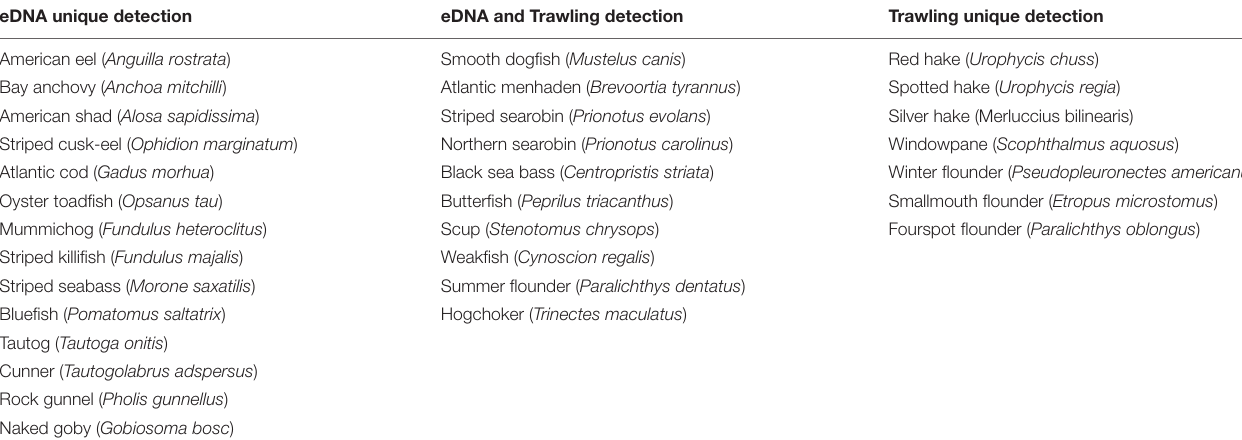
TABLE 4 | Finfish uniquely detected by eDNA, commonly detected by eDNA and trawling, and uniquely detected by trawling on 6/27/2017 in Long Island Sound. eDNA unique detection eDNA and Trawling detection Trawling unique detection American eel ( Anguilla rostrata ) Smooth dogfish ( Mustelus canis